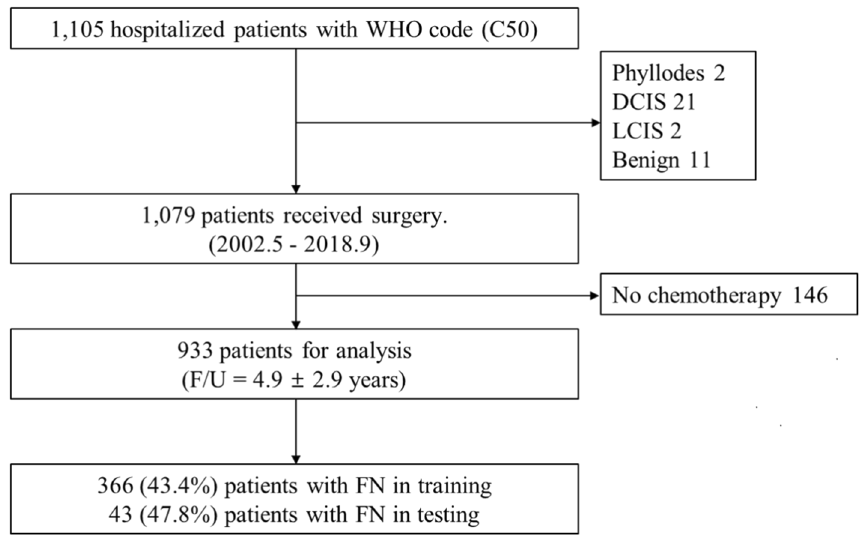
Figure 3. Flow diagram depicting the study design. The image was drawn in Microsoft PowerPoint 2016. WHO World Health Organization, DCIS ductal carcinoma in situ, LCIS lobular carcinoma in situ, F/U follow-up, FN febrile